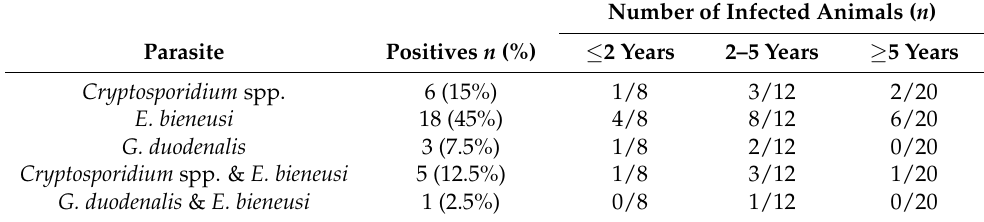
Number of Infected Animals ( n